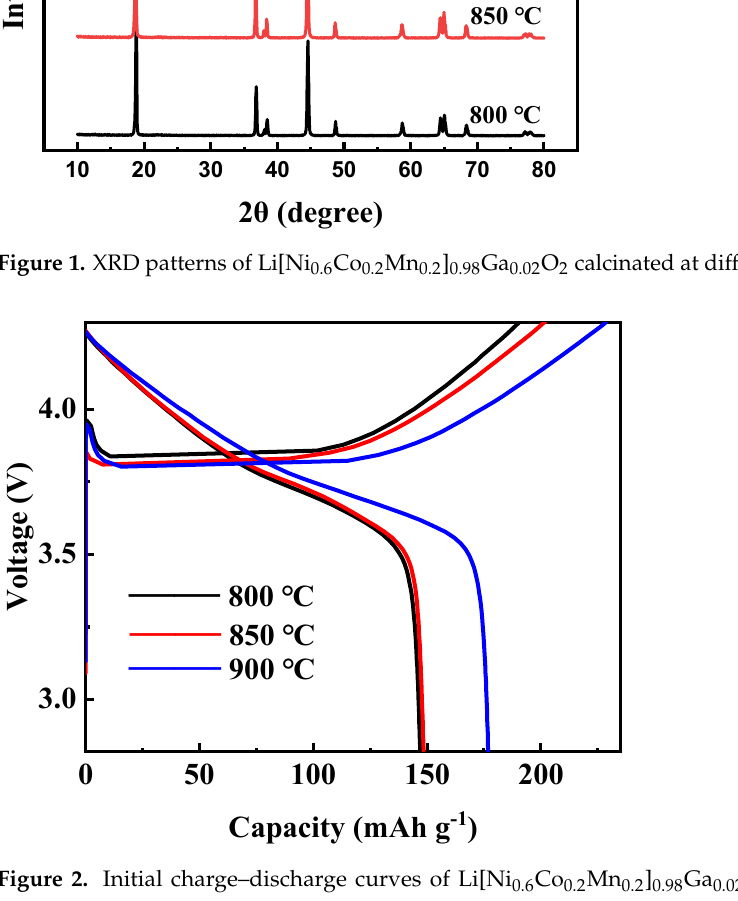
Figure 4. FESEM images of Li[Ni 0.6 Co 0.2 Mn 0.2 ] 1-x Ga x O 2 : x = 0 ( a , f ), x = 0.01 ( b , g ), x = 0.02 ( c , h ), x = 0.03 ( d , i ), x = 0.05 ( e , j ). Furthermore, X-ray photoelectron spectroscopy (XPS) and energy dispersive X-ray (EDX) spectroscopy analysis were carried out for the sample with x = 0.02. As shown in Figure 5a, the photoelectron peak of Ga 3d can be observed in the XPS survey spectra. It can be seen from Figure 5b that the binding energy corresponding to the Ga 3d 5/2 peak is 20.8 eV, which is consistent well with the reported data for Ga 2 O 3 [39], indicating that the valence state of the doped Ga ions remains +3. Figure 6 presents the EDX mapping of the Li[Ni 0.6 Co 0.2 Mn 0.2 ] 0.98 Ga 0.02 O 2 material. As in the case of Ni, Co, Mn, and O atoms, the doped Ga element is also uniformly distributed, which can conform uniform Ga doping in the material. To investigate the effect of Ga doping on the electrochemical performance of Li[Ni 0.6 Co 0.2 Mn 0.2 ] 1-x Ga x O 2 materials, the as-prepared materials were assembled into 2032 coin cells for the charging and discharging tests. Figure 7 shows the initial charge–dis- charge curves (Figure 7a) and the cycling performances (Figure 7b) at 0.5 C (1 C = 200 mA g − 1 ) in the voltage between 2.8 and 4.3 V. The discharge capacity of the samples with Ga content x = 0, 0.01, 0.02, 0.03, and 0.05 were found to be 169.3, 170.1, 177.0, 171.3, and 163.2 mAh g − 1 in the first cycle, and 140.2, 150.4, 158.9, 147.3 and 146.9 mAh g − 1 after 50 cycles, with the capacity retention of 82.8, 88.4, 89.8, 86.0, and 89.7%, respectively. Enhanced dis- charge capacity for the sample with x = 0.02 may be attributed to the improved cation order. However, when the Ga content was x ≥ 0.03, the discharge capacity dropped again, which may be due to the excessive doping of Ga 3+ without electrochemical activity. In addition, the rate performance of Li[Ni 0.6 Co 0.2 Mn 0.2 ] 1-x Ga x O 2 was also investigated, as shown in Figure 8. Among the five samples, the one with x = 0.02 still showed the best electrochemical performance, with a discharge capacity that reached 183.4 mAh g − 1 at 0.2